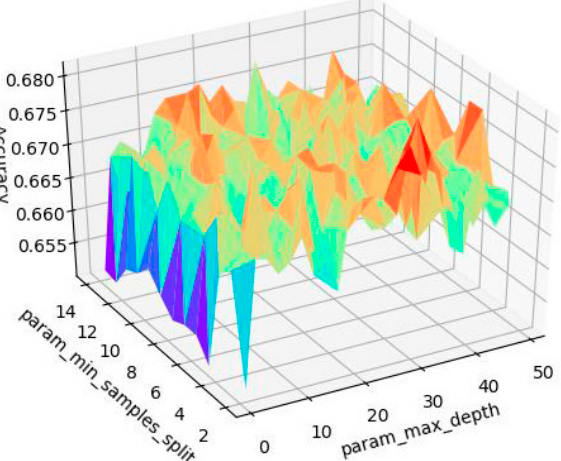
Figure 6. Grid search of random forest. (In this figure, intensive mixed colors like red, yellow etc. show higher values whereas blue, violet etc. single colors show lower values for accuracy corresponding to the values of param_min_samples_spilt and